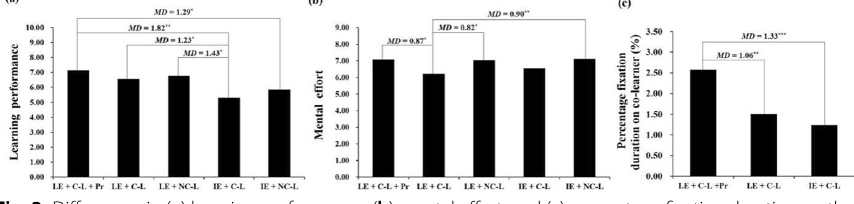
Fig. 3 Differences in ( a ) learning performance, ( b ) mental effort, and ( c ) percentage fixation duration on the co-learner area across the groups (* p < 0.05; ** p < 0.01; *** p <